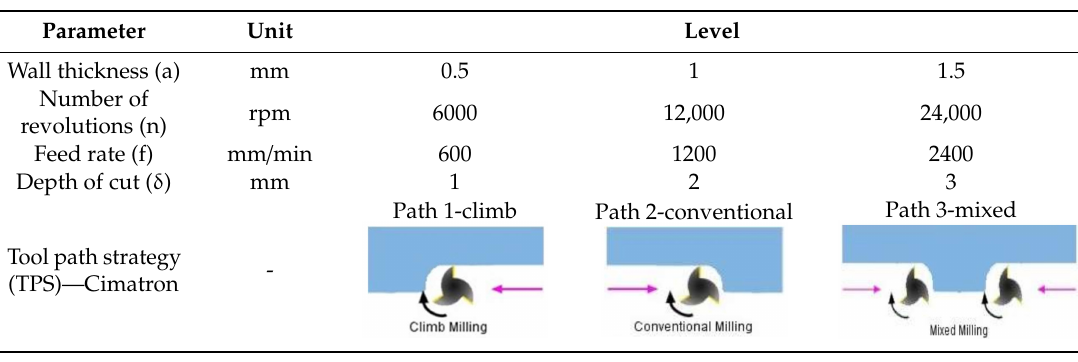
Table 1. Input parameters and levels of